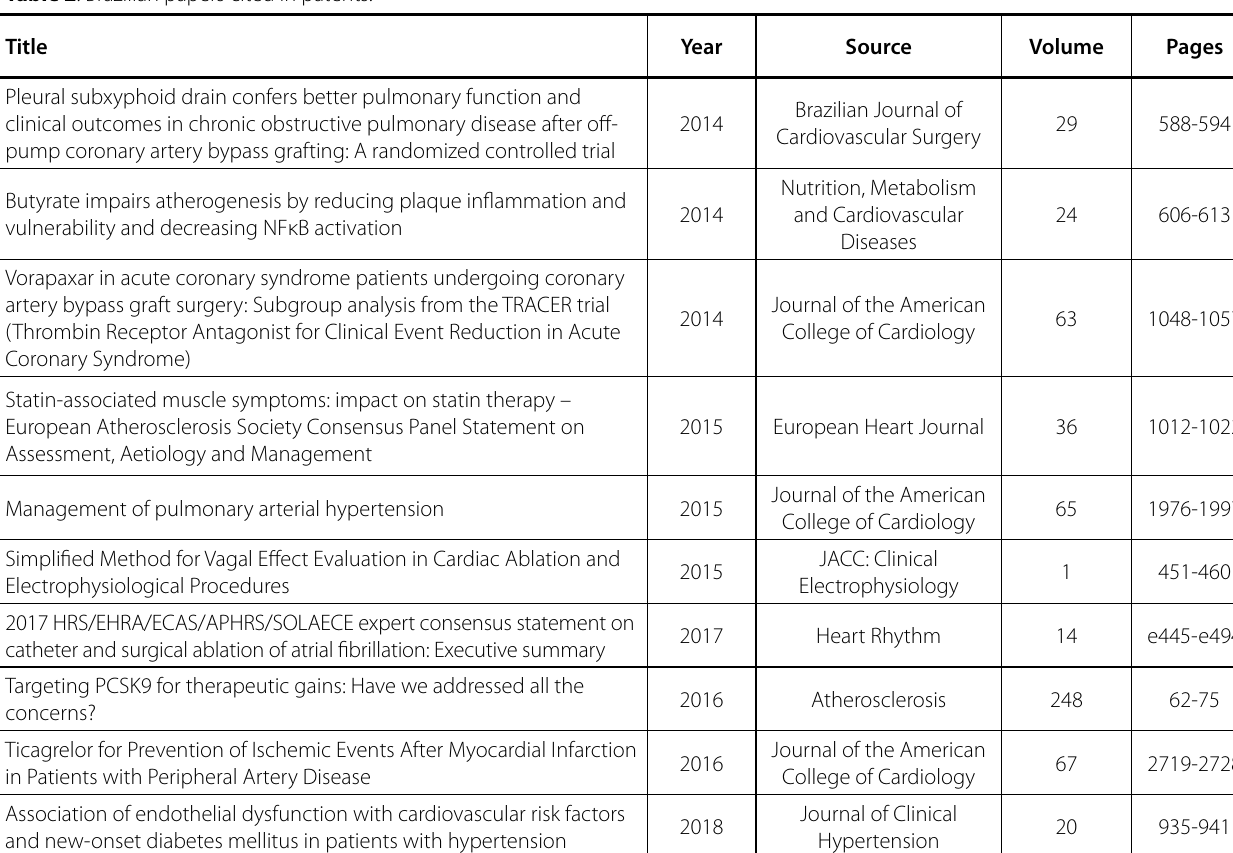
Table 2 . Brazilian papers cited in